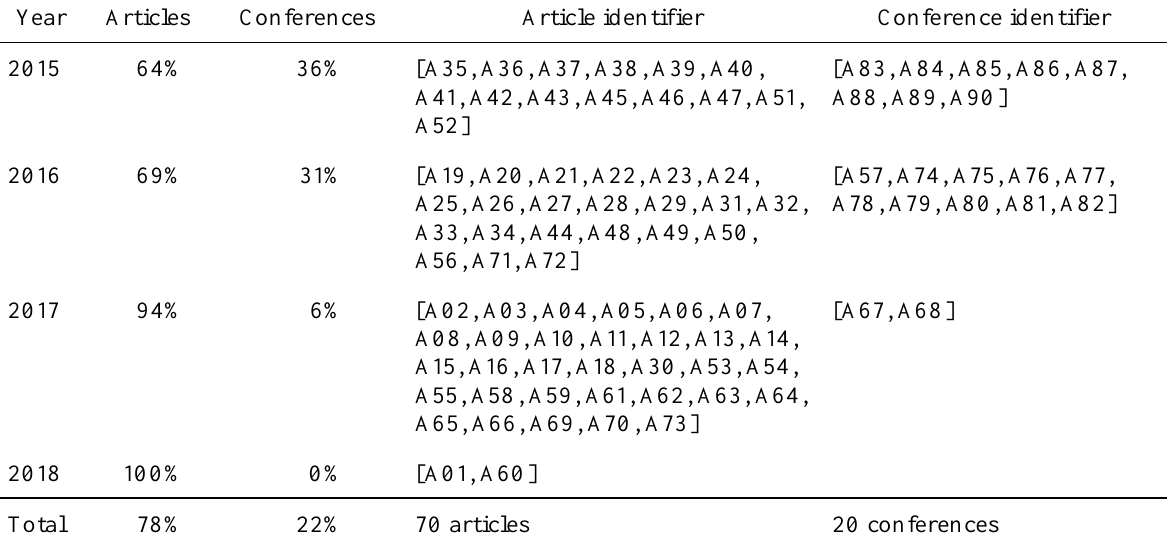
Documents Selected by